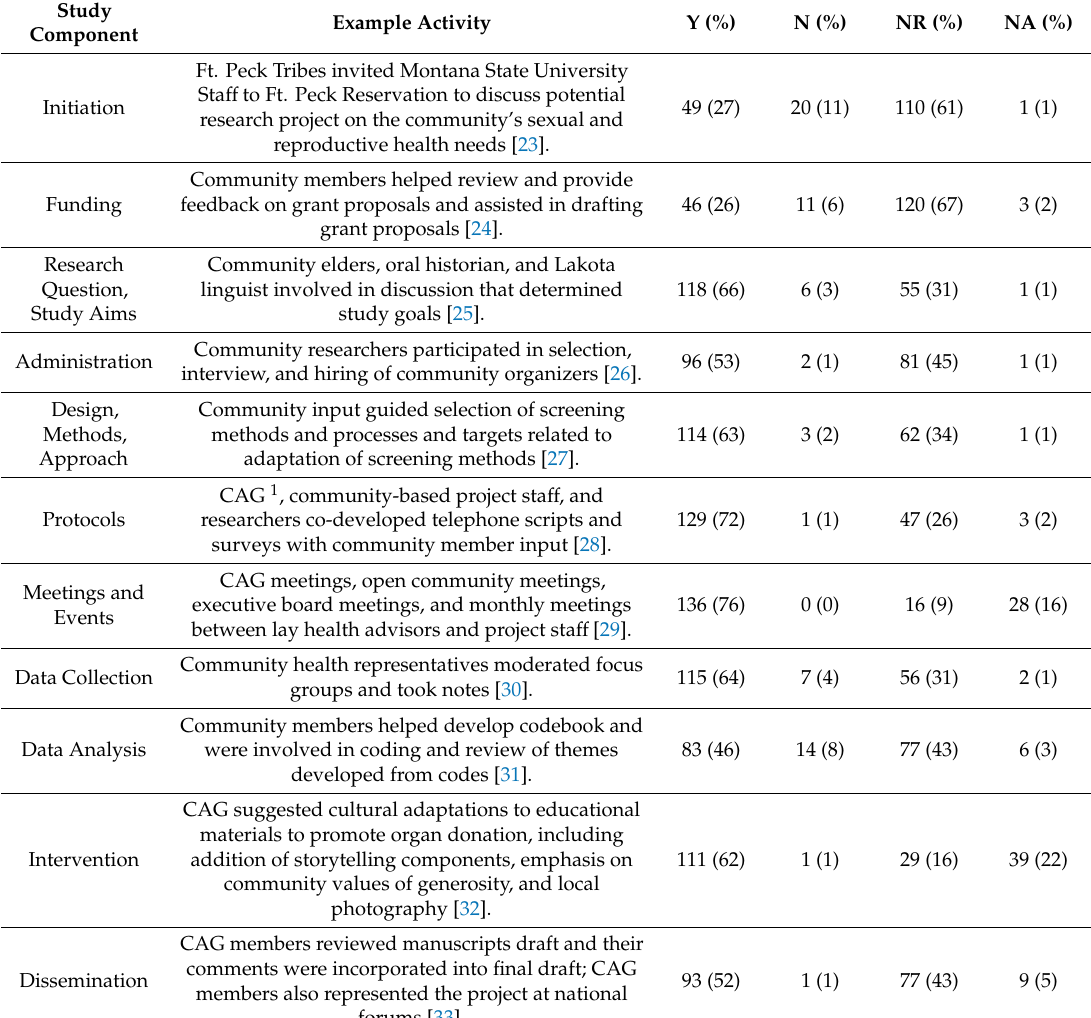
Table 2. Community Engagement in the Research